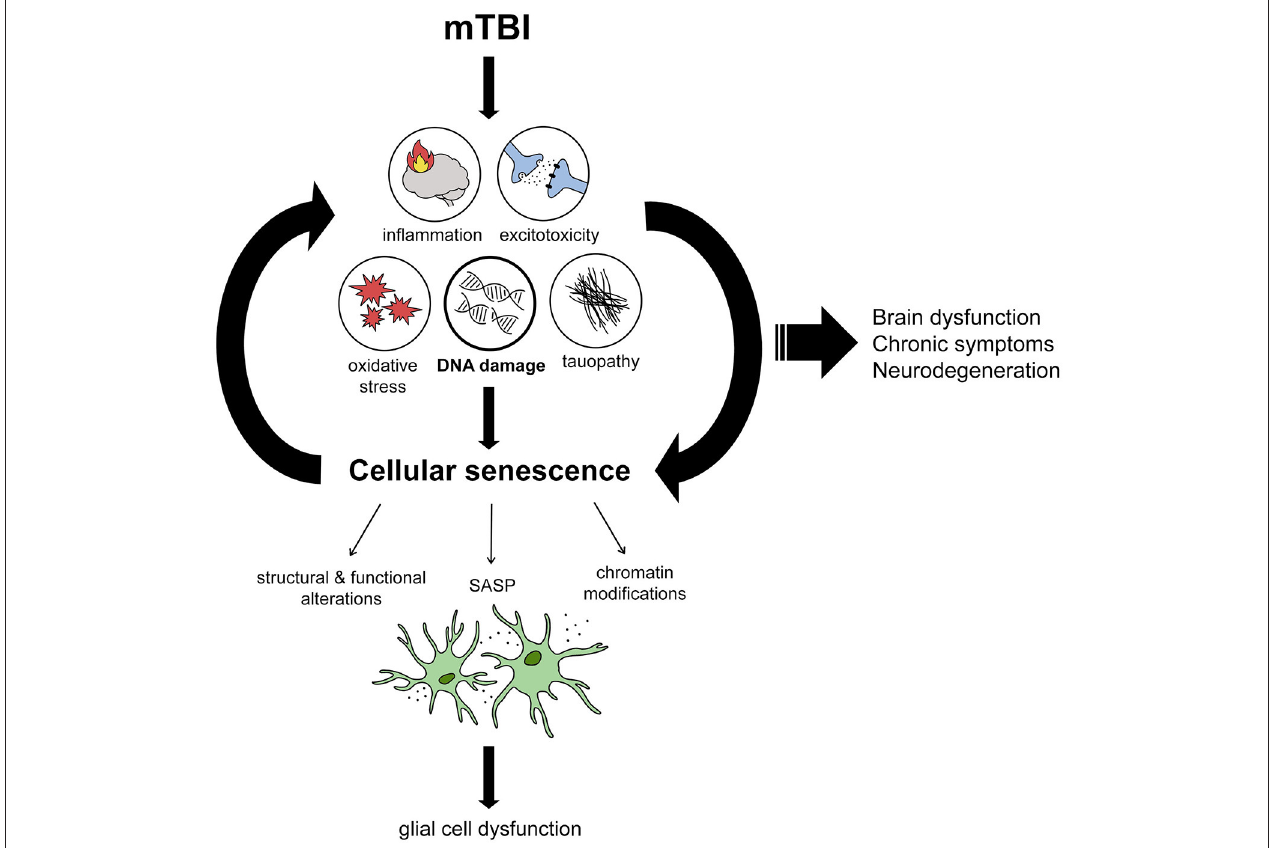
FIGURE 1 | Proposed mechanism by which mTBI leads to brain dysfunction through DNA damage-induced cellular senescence. From reviewing the literature, we propose several immediate effects of mTBI including inflammation, excitotoxicity, oxidative stress, tau dysfunction, and DNA damage which encompasses all the aforementioned features. DNA damage induces cellular senescence when persistent, leading to structural and functional alterations in cells, chromatin modifications changing gene expression signatures, and inflammation by way of the senescence-associated secretory phenotype (SASP). We propose that senescence mostly affects glial cells, resulting in their dysfunction. Cellular senescence acts as a positive feedback loop, with reduced DNA repair and SASP leading to chronic levels of DNA damage and inflammation. We propose that the induction of cellular senescence in this way leads to chronic brain dysfunction and symptoms that are associated with mTBI, including neurodegenerative diseases in the